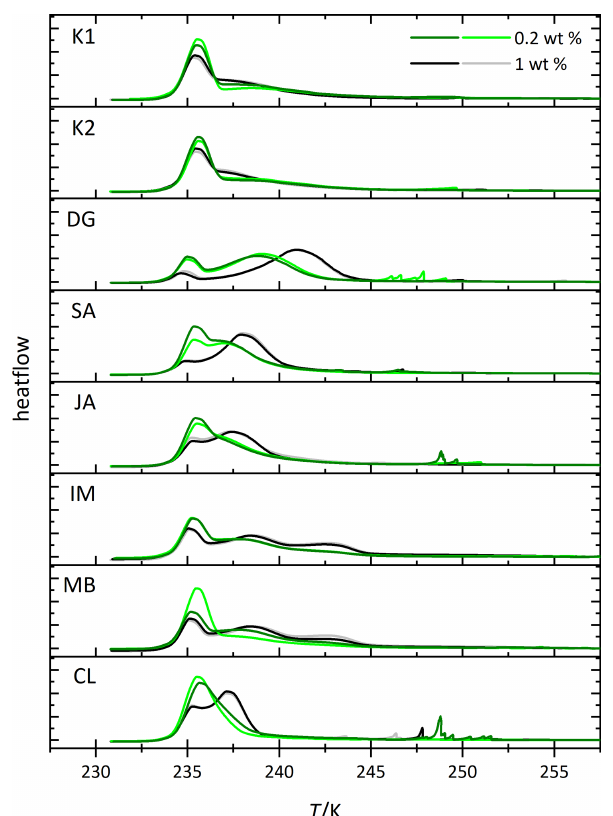
Figure 2. Thermograms from immersion freezing experiments of emulsified kaolinite samples (uppermost two panels) and halloysite samples (lower panels). The DSC was operated at a cooling rate of 1Kmin − 1 . Black and gray lines show the 1.0wt% dust suspen- sions. Dark and light green lines show the 0.2wt% dust suspen- sions. The curves are normalized with respect to their total integral. Spikes occurring before the heterogeneous freezing signal originate from single large emulsion droplets and are not representative of ice nucleation by halloysite/kaolinite. Dust sample codes for kaolin- ites are K1 for KGa-1b (well-ordered kaolinite) and K2 for KGa-2 (poorly ordered kaolinite). Dust sample codes for halloysites are as follows: DG is dragonite (Dragon Mine, Utah, USA), SA is Sigma- Aldrich (Utah, USA), JA is Jarrahdale (Western Australia), IM is I-Minerals, Inc. (Idaho, USA), MB is M¯atauri Bay (New Zealand), and CL is Camel Lake (South Australia). See Table 1 for morpho- logical and compositional